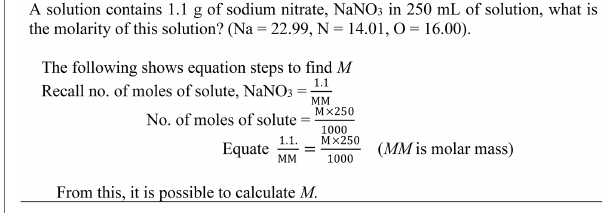
FIGURE 2 | An equation worked example. Source: Ngu and Yeung